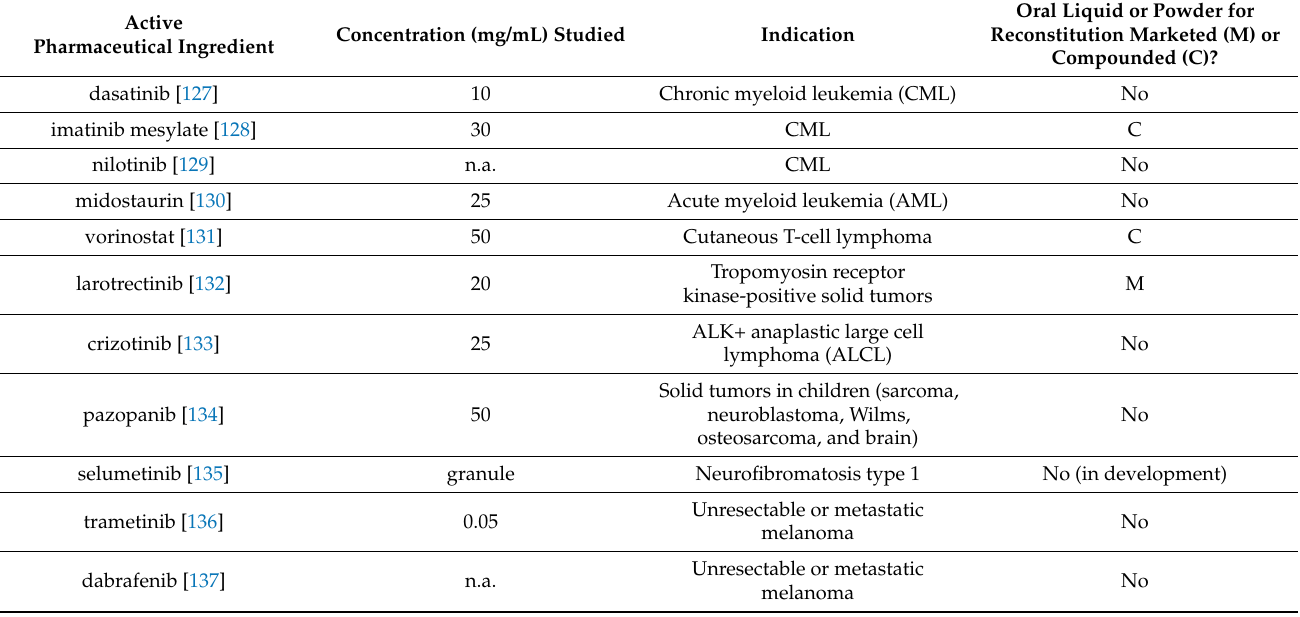
Table 6. Selected pediatric cancers treated with targeted therapies and availability of oral